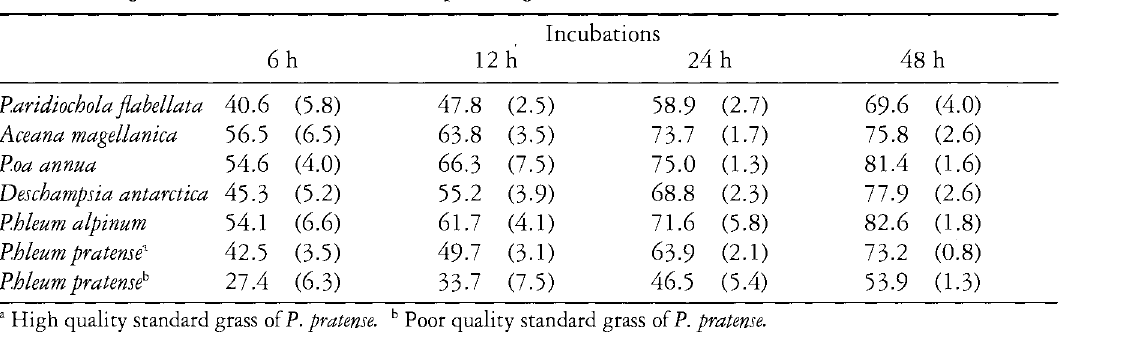
Table 3. Mean (standard deviation) in vitro dry matter digestibility of plants selected by Norwegian reindeer on South Georgia in summer and of two standard plants digested for 6, 12, 24 and 48 h in fresh rumen fluid (n =